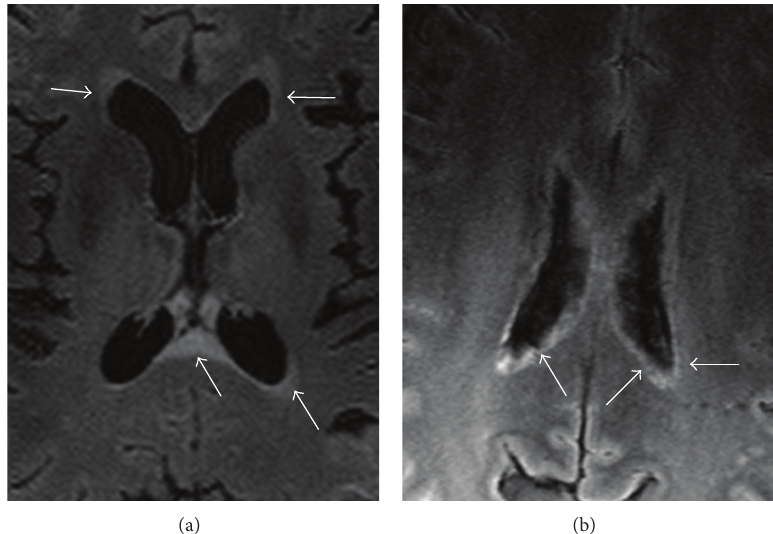
F 3: Examples of diffuse periependymal abnormalities. Abnormal and thickened signal intensities (arrows) along ependymal layers on FLAIR images in two patients ((a) and